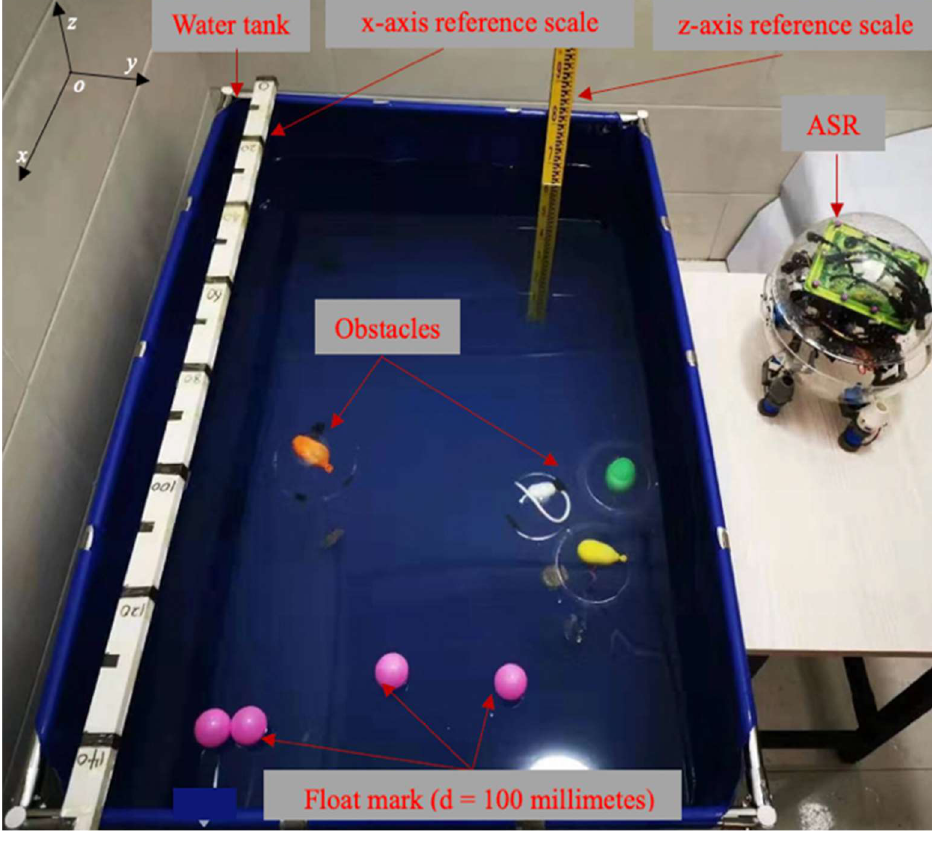
Figure 14. Experimental setup of underwater path-planning.